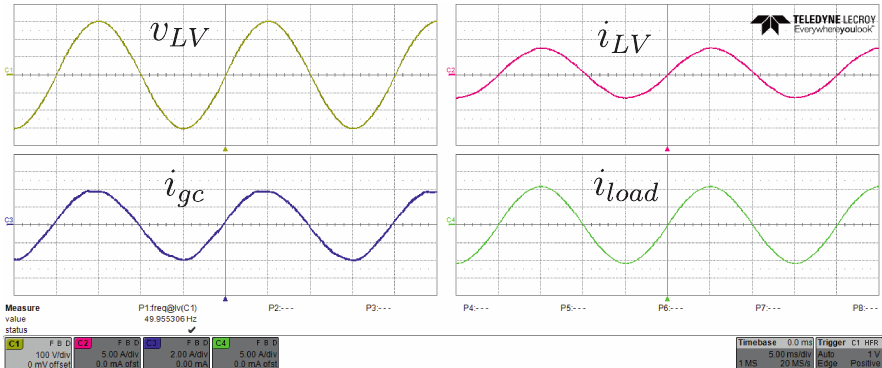
Figure 10. Steady-state before the overload (Figure9, orange box): ST voltage (yellow line, 100V/div), ST current (magenta line, 5A/div), DG current (blue line, 2A/div), load current (green line, 5A/div).